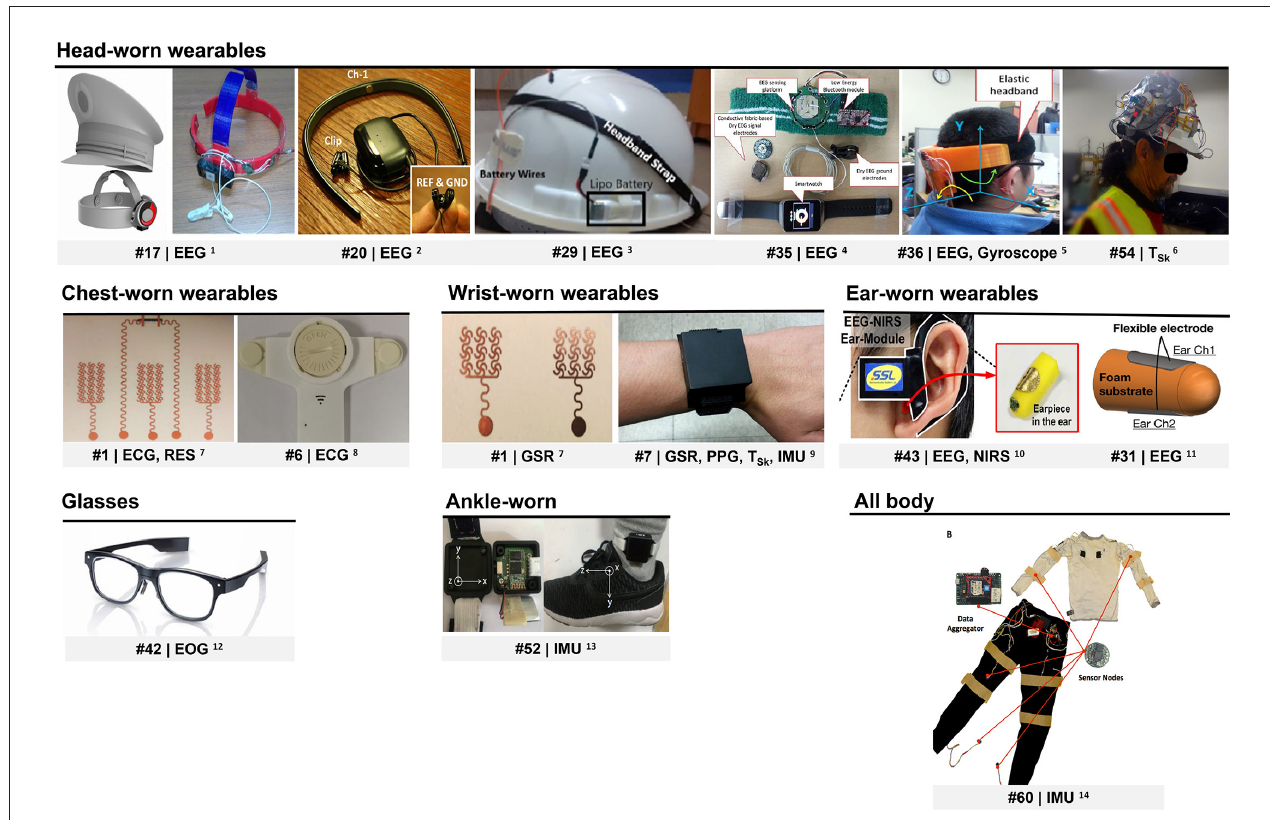
FIGURE 3 | Wearables devised for fatigue monitoring. ECG, electrocardiogram; EEG, electroencephalogram; EOG, electrooculogram; GSR, galvanic skin response; IMU, inertial motion unit; NIRS, near-infra-red spectroscopy; PPG, photoplethysmography; RES, respiration; T Sk , skin temperature. 1 Reprinted from Zhang et al. (2017) . 2 © (2015) IEEE. Reprinted, with permission, from Ko et al. (2015). 3 Reprinted from Dhole et al., (2019). © (2019) with permission from Elsevier. 4 © (2015) IEEE. Reprinted, with permission, from Li et al. (2015). 5 Reprinted from Li and Chung (2015). 6 Reprinted from Aryal et al. (2017). © (2017) with permission from